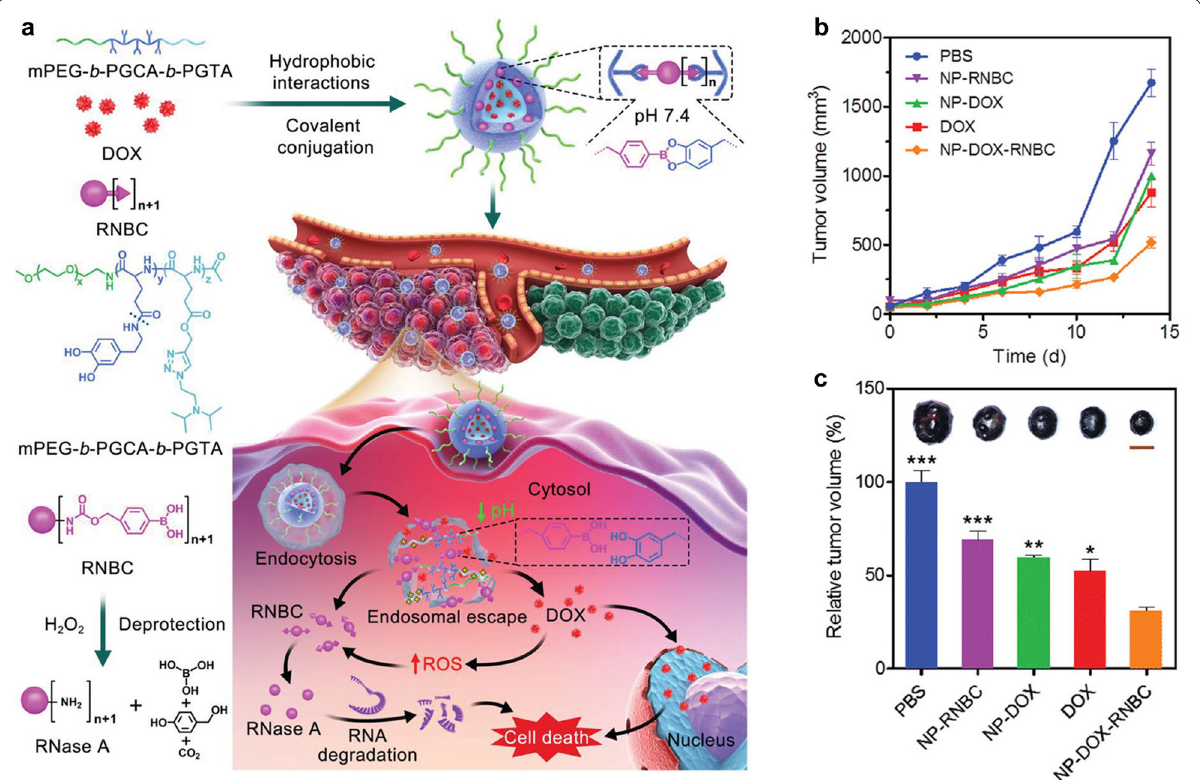
Fig. 2 a Schematic illustration of the intracellular co-delivery of RNase A and DOX using a multistage cooperative drug delivery nanoplatform formed by mPEG-b-PGCA-b-PGTA for combination cancer therapy. b Tumor volume changes of B16F10-tumor-bearing mice after intravenous injection of PBS, NP-RNBC, NP-DOX, DOX, and NP-DOX-RNBC on day 0, 3, 6, and 9. c Relative tumor volume of the mice treated as described in ( b ) on day 14. Inset: Representative photographs of the excised tumors from the mice treated as described in ( b ) on day 14. Reproduced with